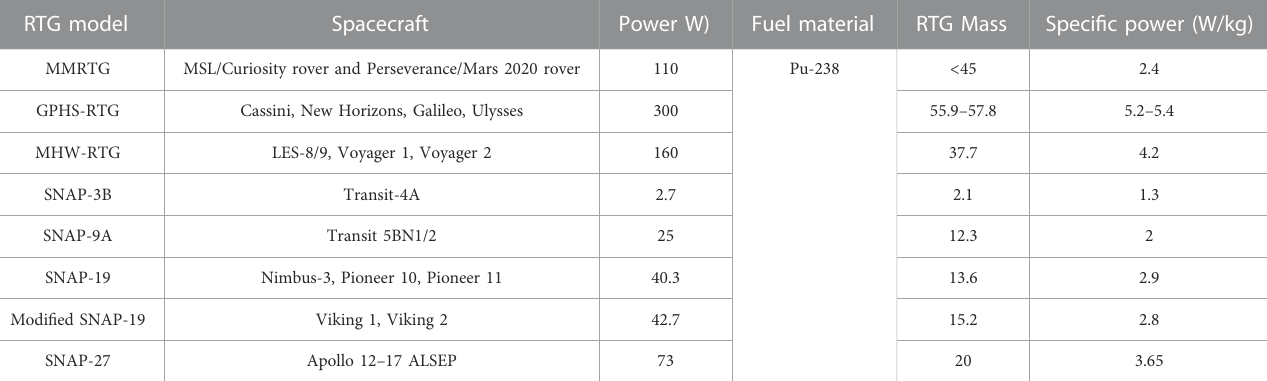
TABLE 1 RTGs used in spacecraft (Bennett, 2006; Bennett, 2018; Woerner, 2018; Clarke et al., 2022). RTG